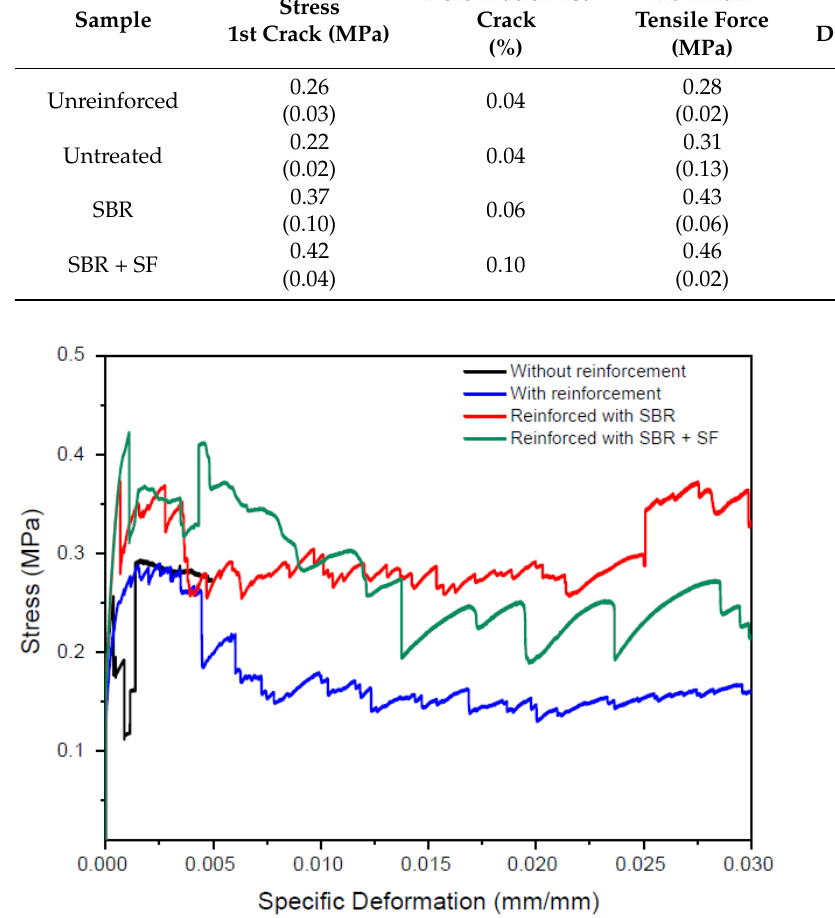
Figure 10. Stress vs. deformation of the concrete